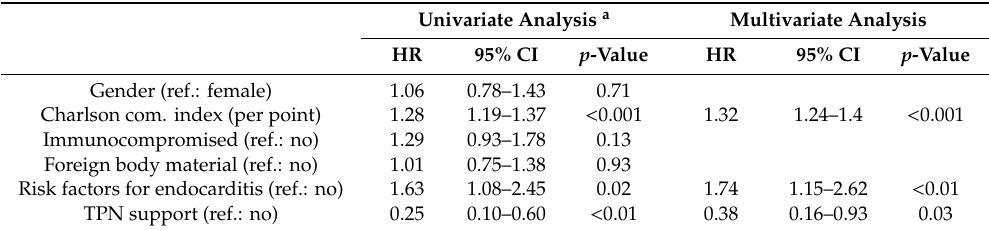
Table 4. Cox proportional hazard model for overall mortality with patient